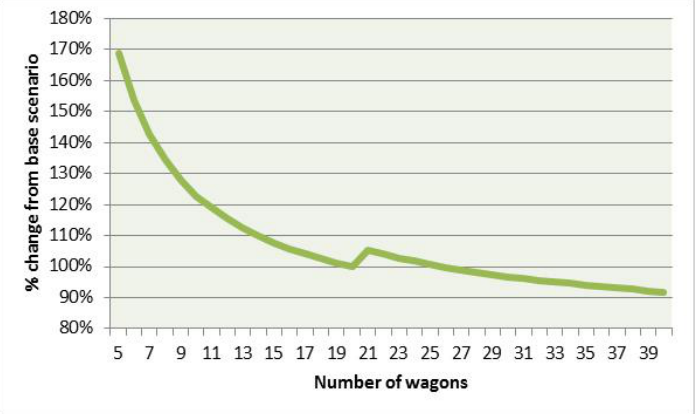
Figure 9. The effect of train